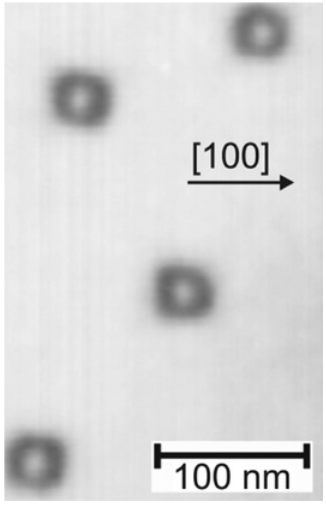
Figure 1: High-resolution top-view transmission electron micro- scopy picture of a layer of InAs/GaAs QDs, showing four pyramidal